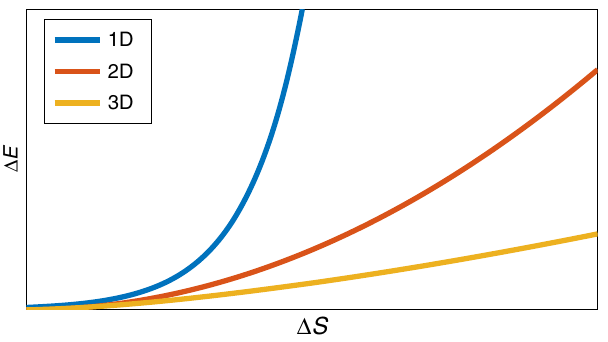
Fig. 2 Energy cost of entanglement extraction from quantum fi eld vacua: this depends heavily on the spatial dimension. Here we sketch the behaviour in dimensions d = 1, 2, 3. When d = 1, Δ E ∝ exp( K Δ S ), where K is a constant, and for d > 1, Δ E ∝ Δ S d /( d −